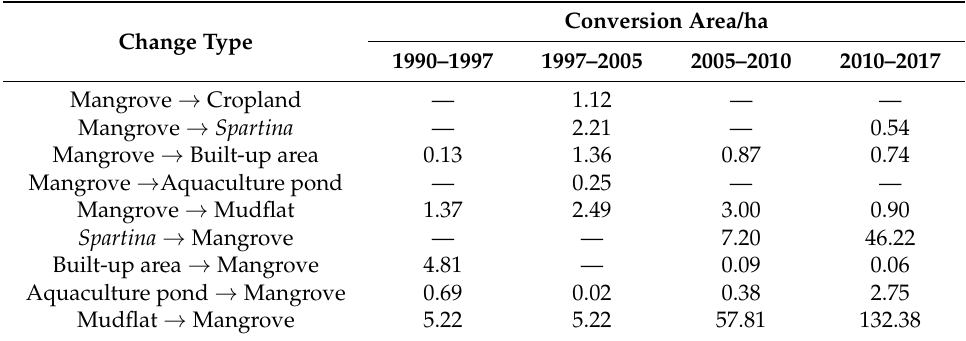
Table 5. Conversion comparison between mangrove forests and other land cover types in the Quanzhou Bay Estuary Wetland Nature Reserve